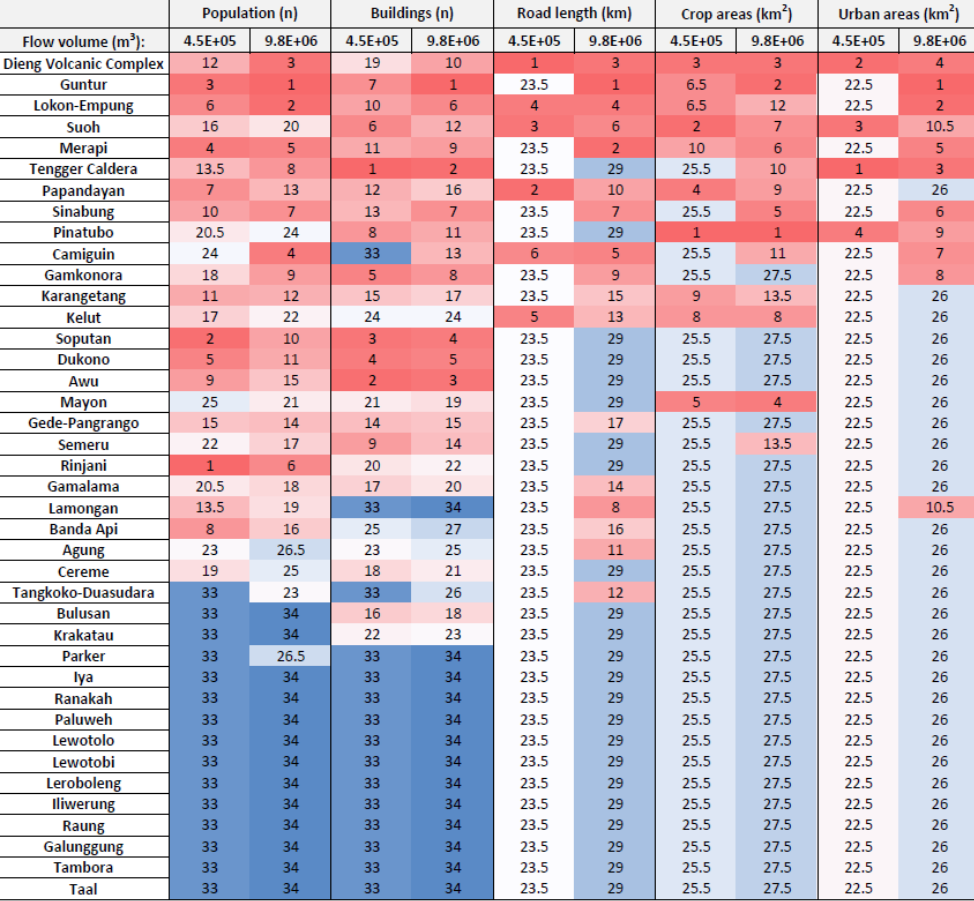
Figure 14. Individual rankings for calculated population exposure for the 50% dome collapse PDC hazard for all volcanoes across the five exposure categories. Exposure is provided for the smaller and larger volume scenarios using the 990m buffer. Volcano order and cell colour same as for Fig. 12. Dome collapse PDCs are not VEI dependent, and so the absolute ranks are not calculated, and these results are therefore applicable to the conditional